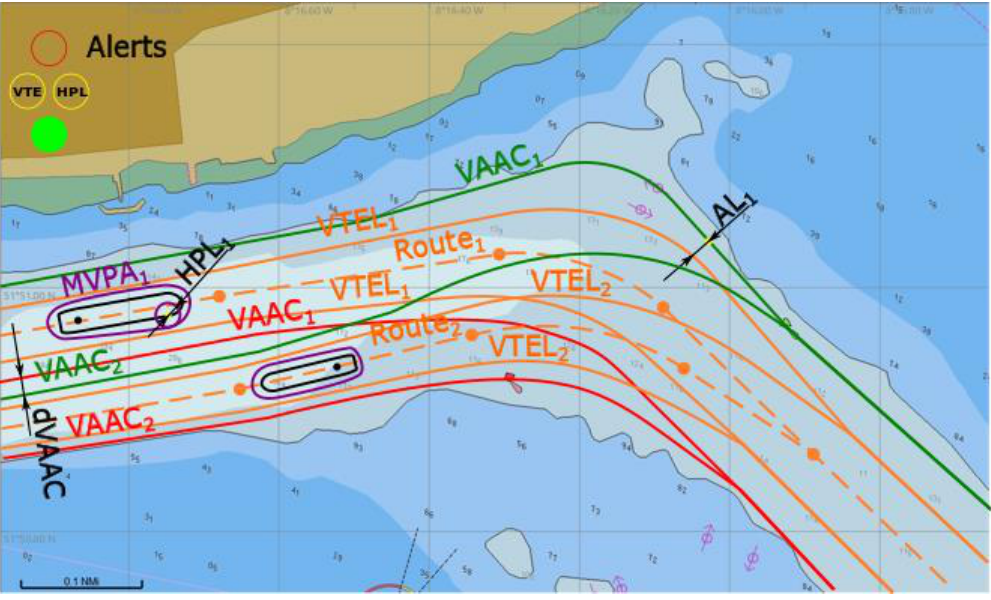
Figure 15. Safe operation in a two way waterway, conceptual presentation in ECDIS.